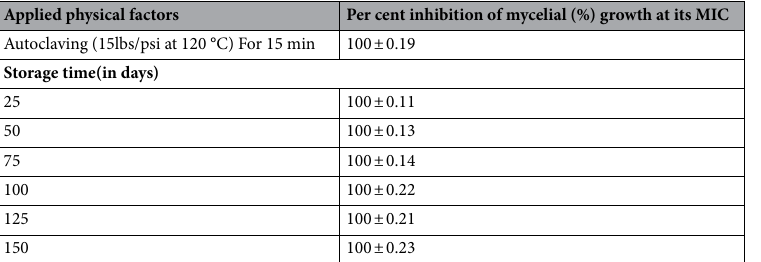
Applied physical